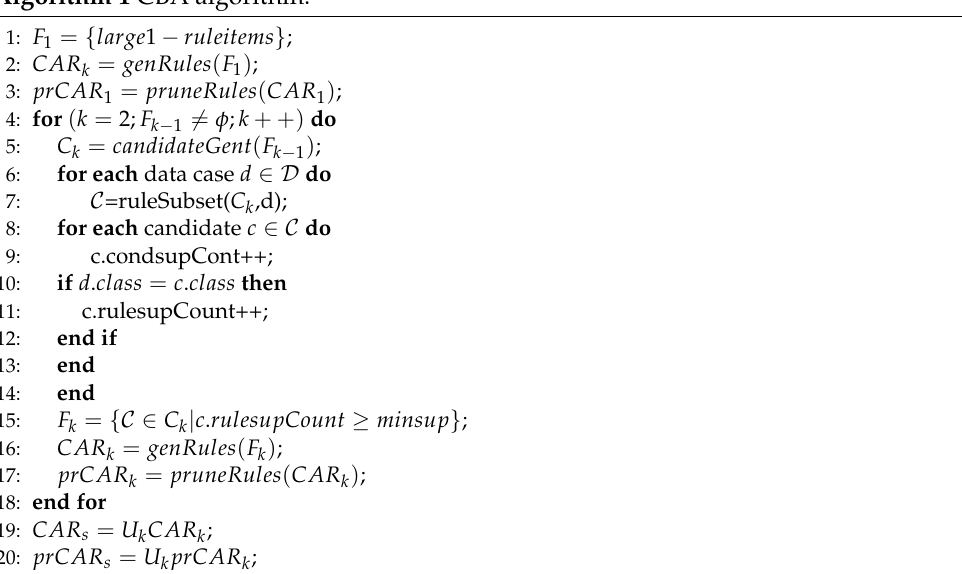
Algorithm 1 CBA